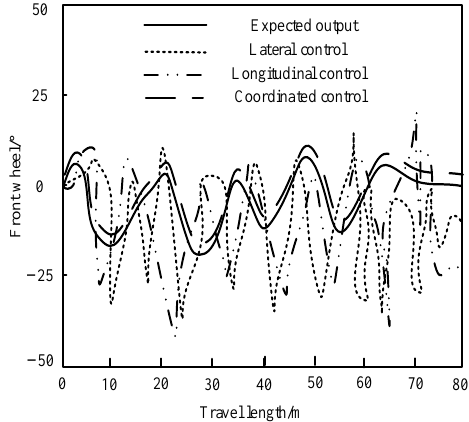
Figure 8. Control results of front wheel angle.